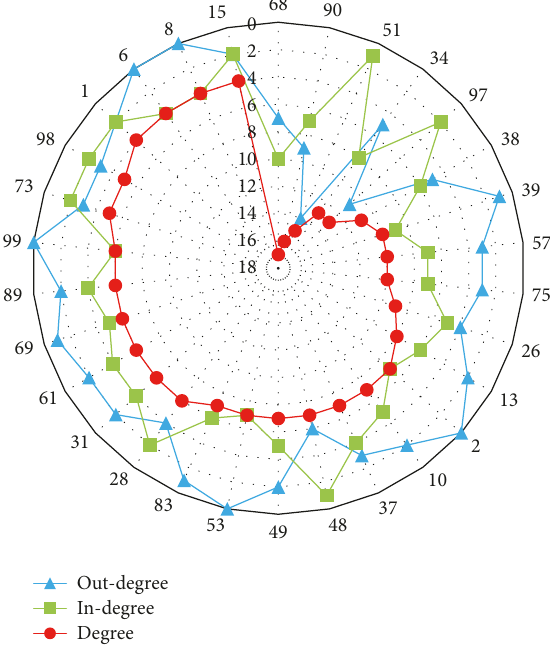
Figure 6: In-degree, out-degree, and total degree